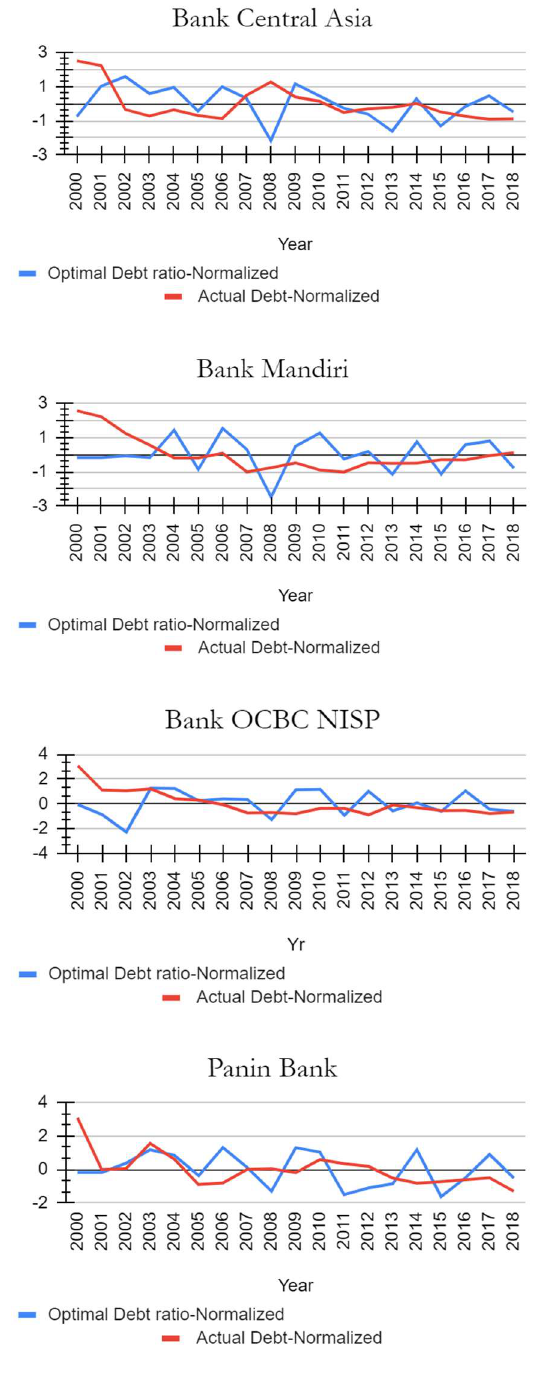
Figure 1. Optimal versus actual debt ratio for conventional banks. Source: author’s calculations.